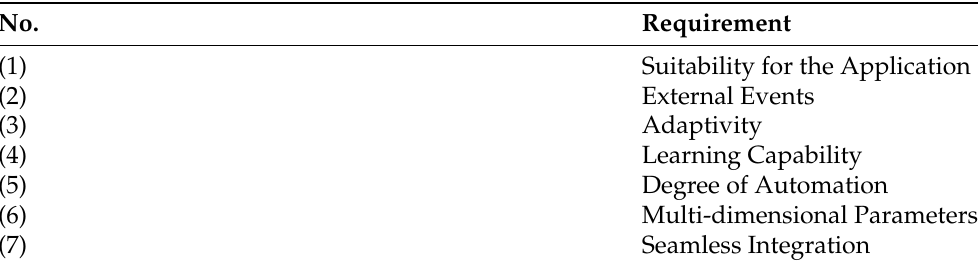
Table 2. Requirements for the concept to effectively link supply network events and